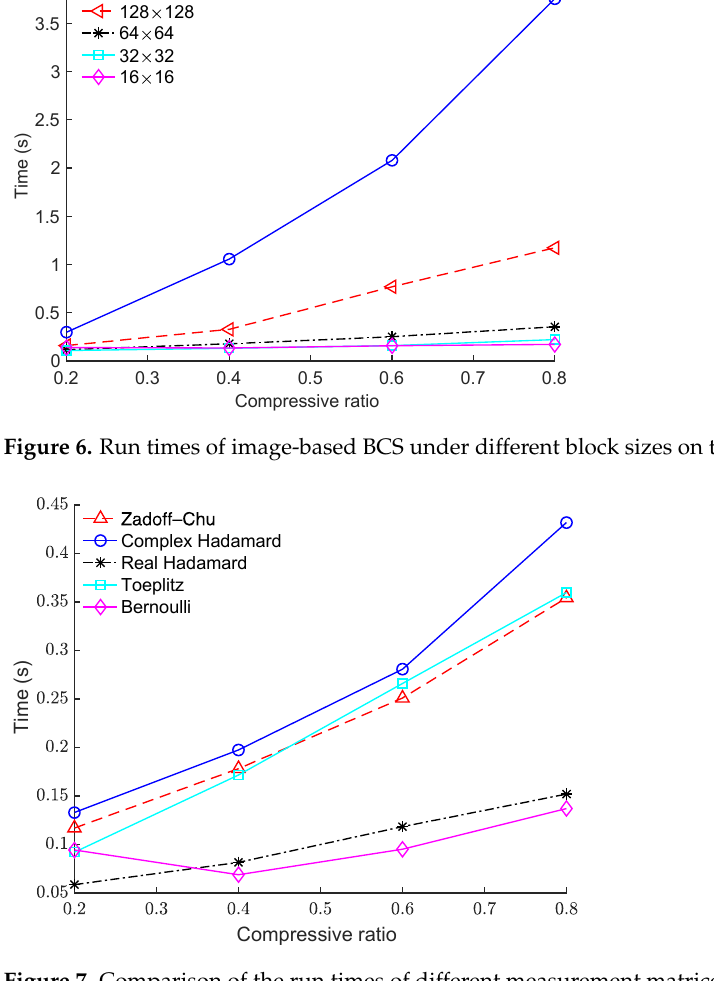
Figure 6. Run times of image-based BCS under different block sizes on the “House” image.